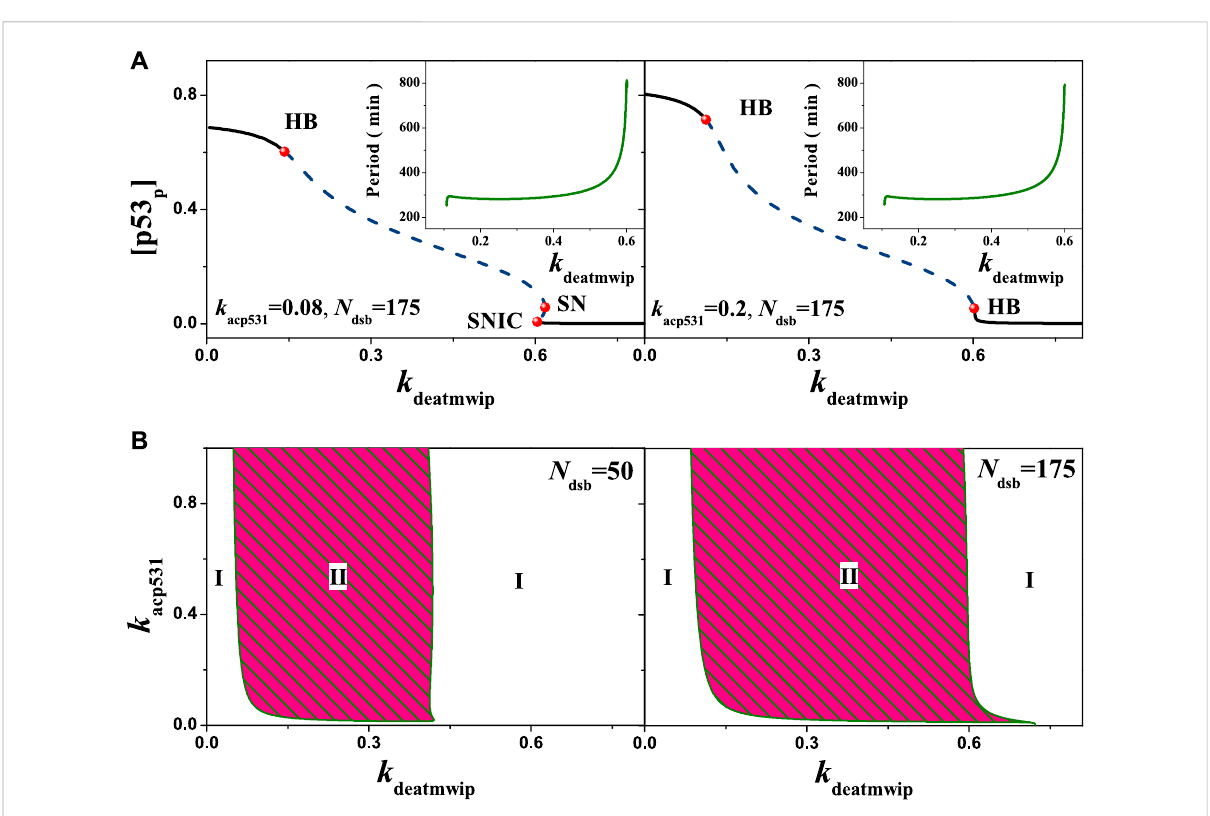
In fl uencesoftheATMregulatedp53phosphorylationonthenetworkdynamicswithdifferentstrengths. (A) Oneparameterbifurcationdiagram of [p53 p ] on the parameter k deatmwip . From left to right, k acp531 = 0.08 and 0.20 respectively. The schematic diagram shows the relationship between theperiod and theparameters k deatmwip . (B) The two-parameter bifurcationwith respect to k deatmwip and k acp531 . The symbols ‘ I ’ , ‘ II ’ and ‘ III ’ represent monostable state, oscillation state and excited state respectively. From left to right, N dsb = 50 and 175 respectively. Either in A or B, the same ordinate system is used for the left and right graphs.